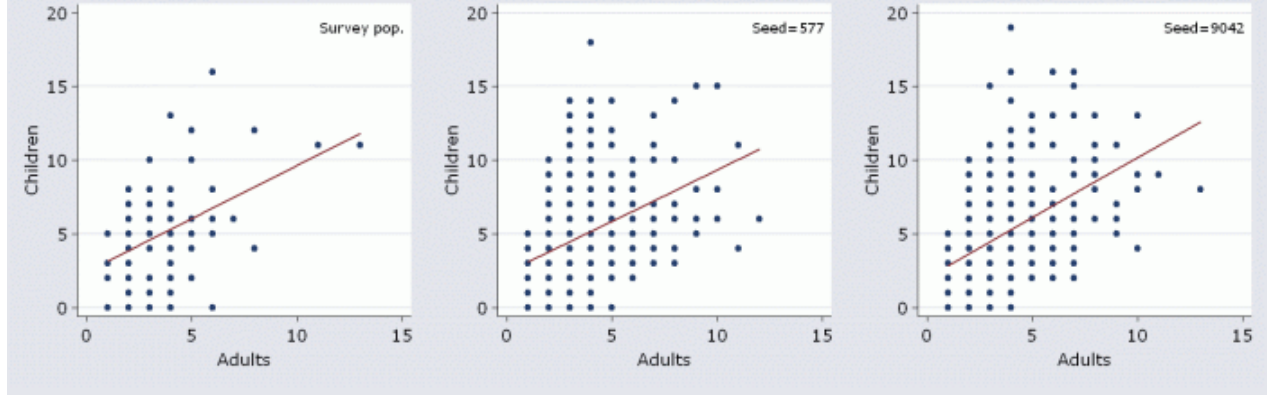
parameterization of agents, representing real-world farm households. The paper outlined a method to generate agent populations from farm household survey data in combination with spatial data on the location of plots and farmsteads and the quality of